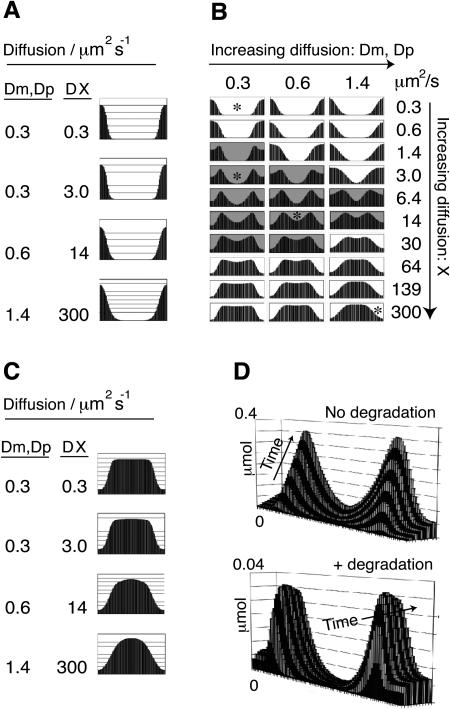
Varying Diffusion and Degradation ParametersComputer model of gene network, scaled to Drosophila length (0.5 mm). Diffusion parameters are varied for mRNA (Dm), protein (Dp), and T7 activator (DX). Data are plotted as percentage of total output protein (y-axes) against chamber position (x-axes), for 10-min simulations.(A) Outputs for protein A.(B) Output for protein B. Graphs with “target behaviour” are shaded grey, and the four asterisks mark the parameter sets used to generate outputs for proteins A and C.(C) Outputs for protein C.(D) Effect of adding protease degradation to B-output, shown at 15-min intervals, over a 2.5-h time course (parameters: DX = 0.43 μm2s−1; Dm = Dp = 0.02 μm2s−1; t1/2 = 770 s).